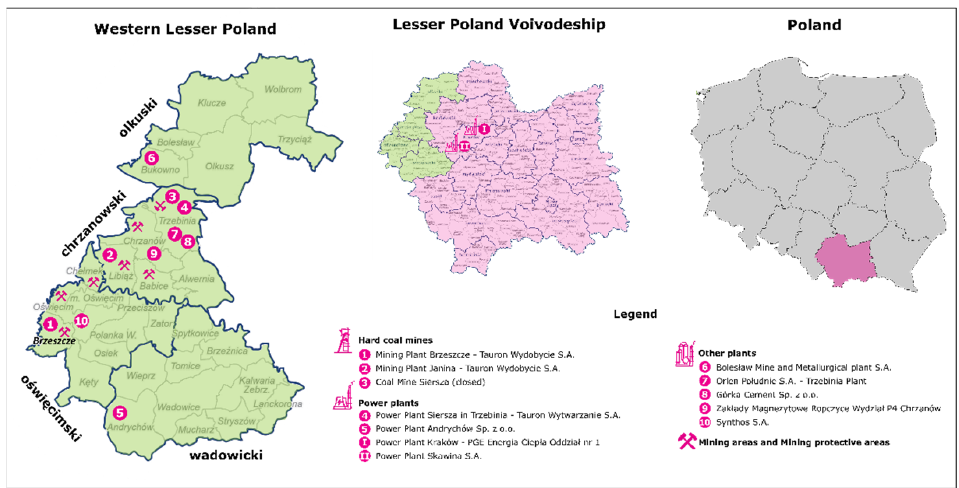
Figure 4. Location of mining plants, power plants and other energy-intensive and carbon-intensive enterprises in Western Ma ł opolska (source: own study).